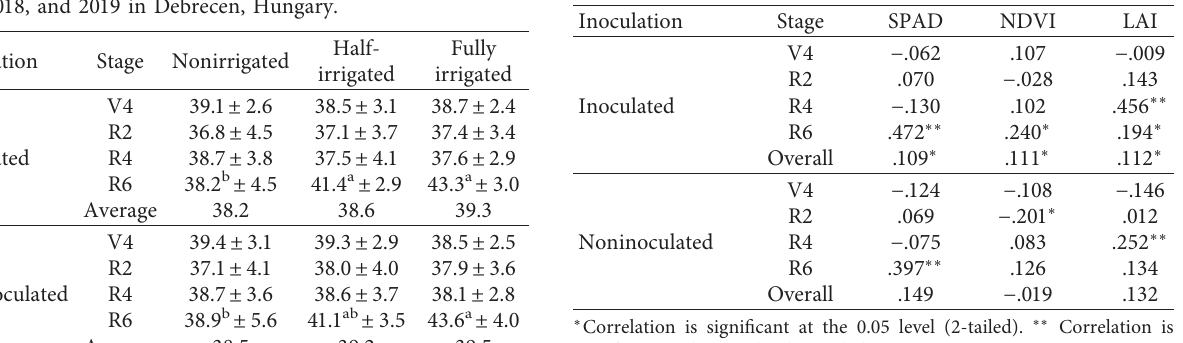
Table 4: Correlation coefficient of SPAD, NDVI, and LAI traits at different stages with irrigation.